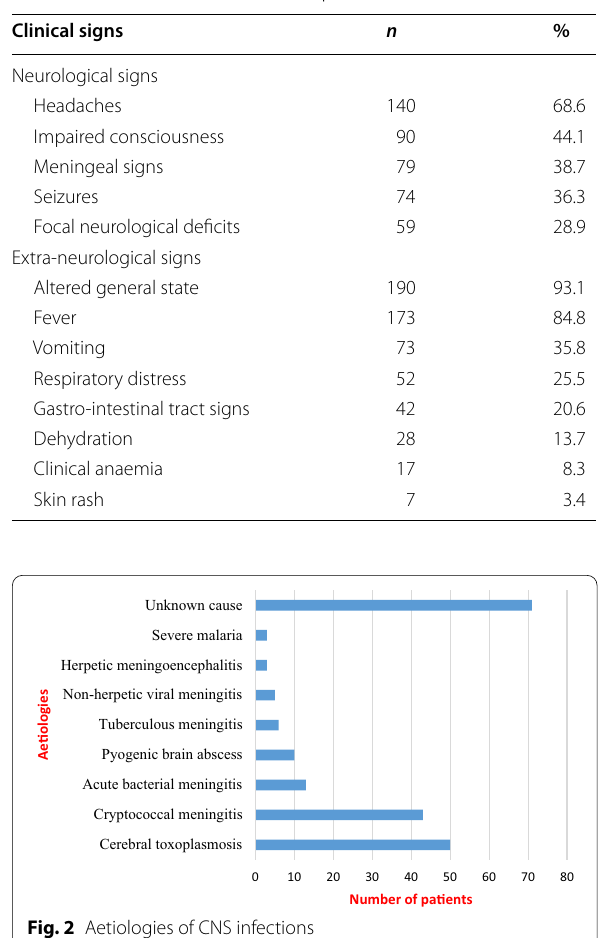
Table 2 Clinical manifestations in patients with CNS infections